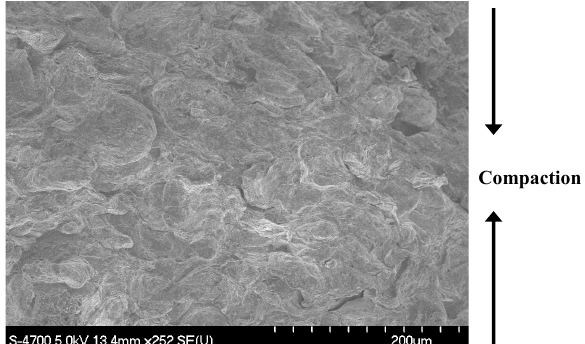
Figure 11. ow magnification SEM micrograph of P/M AZ31 alloy sintered at 600 °C (500 MPa, 60 min, 375